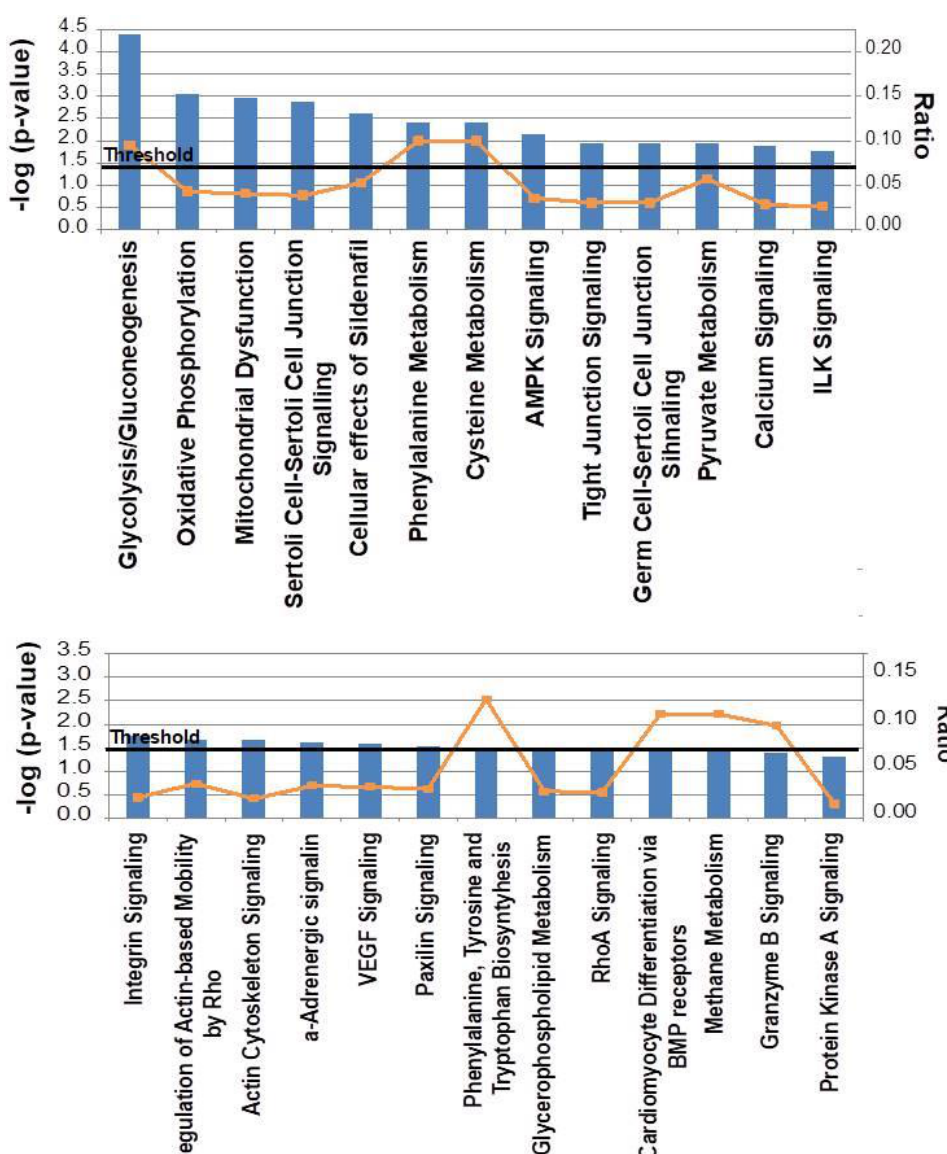
Figure 3. Canonical pathways significantly regulated in hCOX-2 Tg mice. Bioinformatic analyses were performed using IPA software. The most statistically significant canonical pathways are listed according to their p value ( − log) (blue bars) and the ratio of the list of genes found in each pathway over the total number of genes in that pathway (orange squares). The threshold line corresponds to a p value of 0.05.